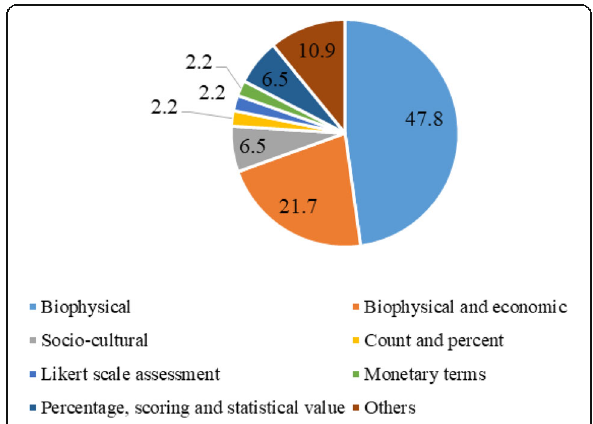
Fig. 6 Methods of assessments used by the selected publications